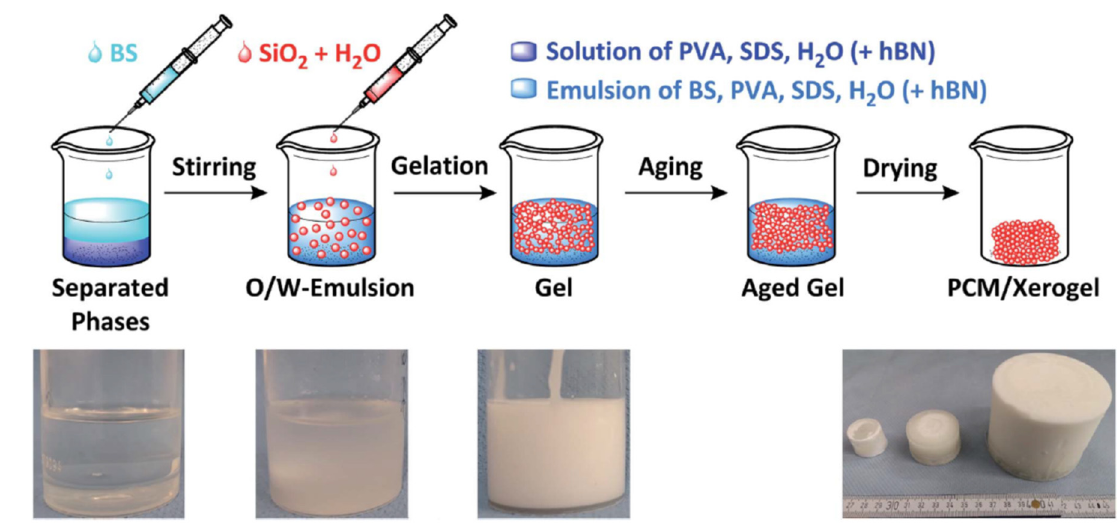
Figure 9. Schematic representation of butyl stearate monolith synthesis. Reproduced from [130]. Published by The Royal Society of Chemistry, under CC BY-NC 3.0 license.